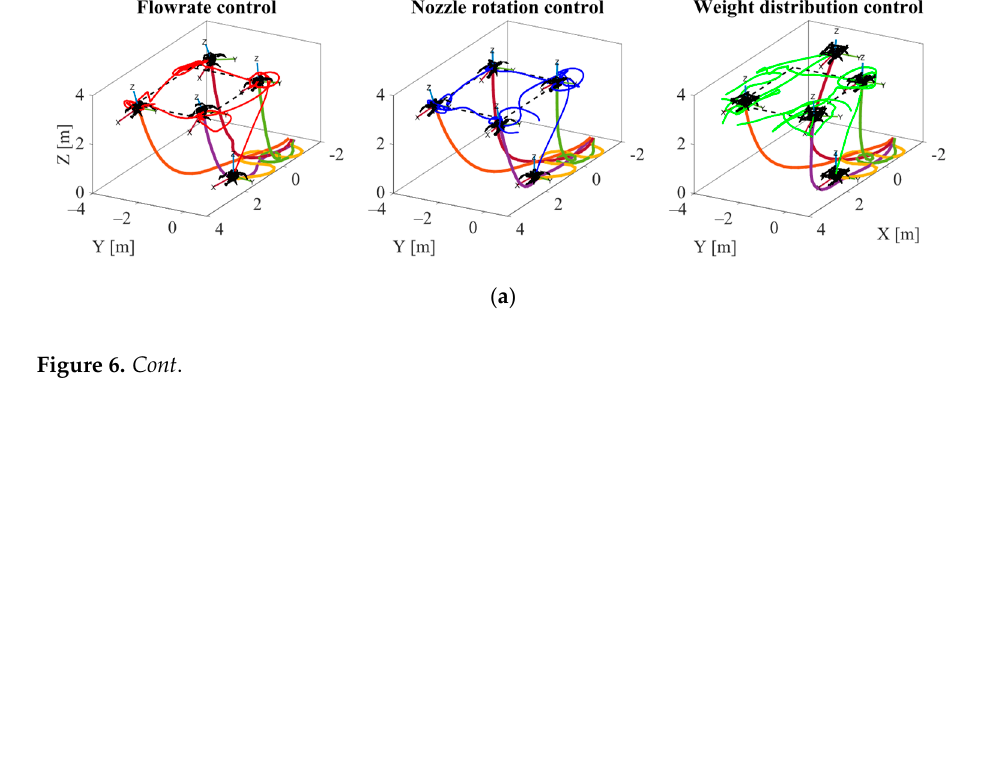
Figure 5. Motion performance of the proposed designs. ( a ) Tracking performance in three-dimensional geometry; ( b ) Time responses of translations and rotations; ( c ) three-dimensional partial motion of the water-conveying hose; ( d ) Control inputs.